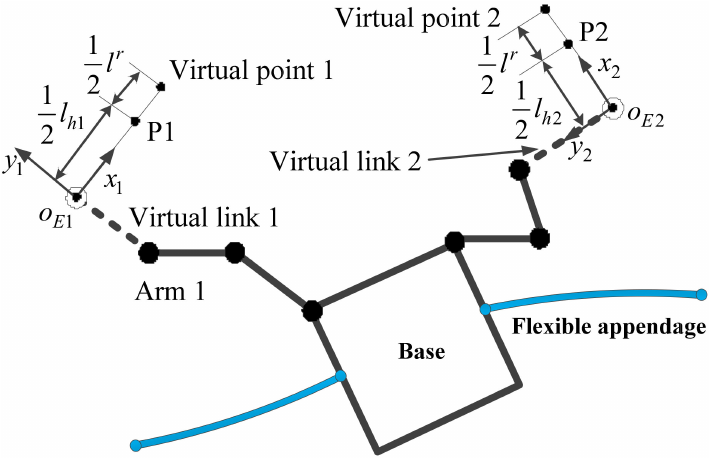
Figure 5. Virtual points created in the preassembly